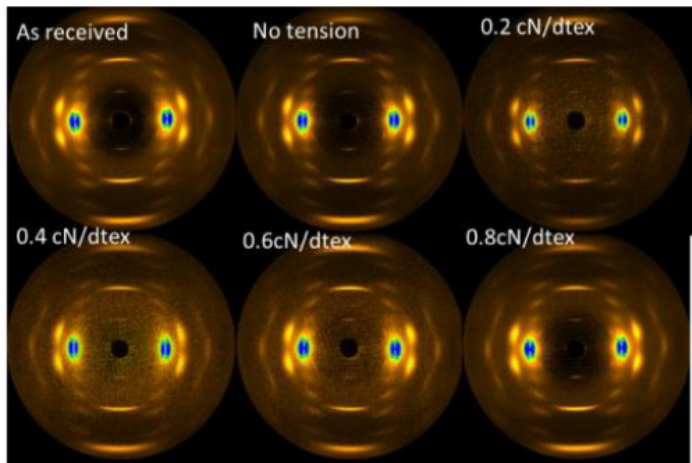
Figure 6. WAXS patterns of Kevlar 49 fibers under various tensions.